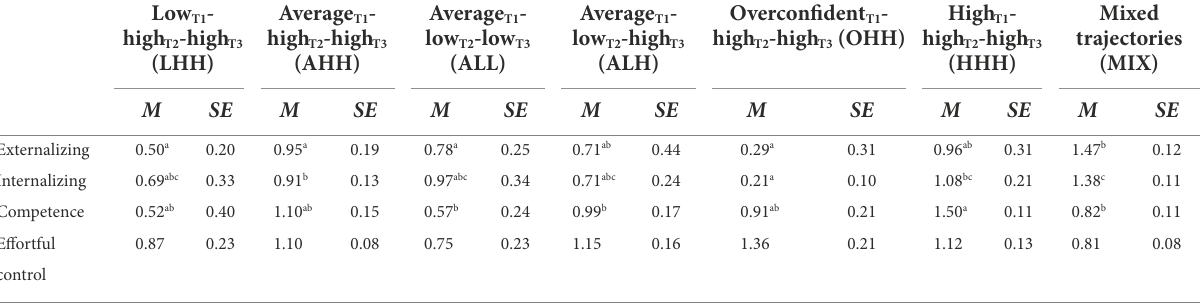
TABLE 6 Associations between the maternal PRF Trajectories (T1-T3) and child outcomes at the age of 2 years